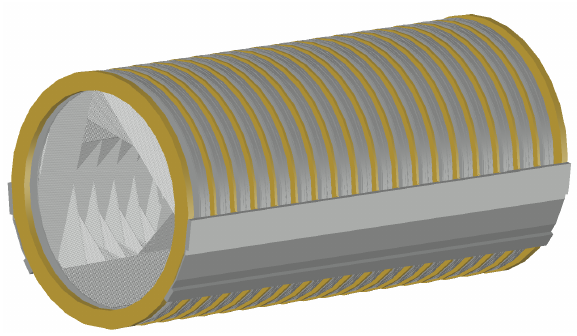
Figure 5. Sketch of Mu2e Tracker